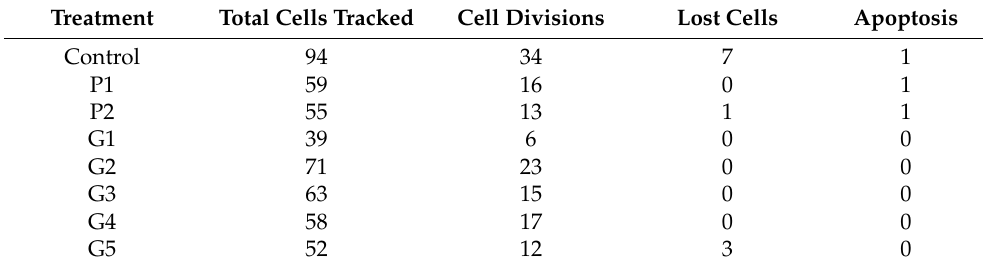
Table 2. Summary of the observed fate of tracked cells.